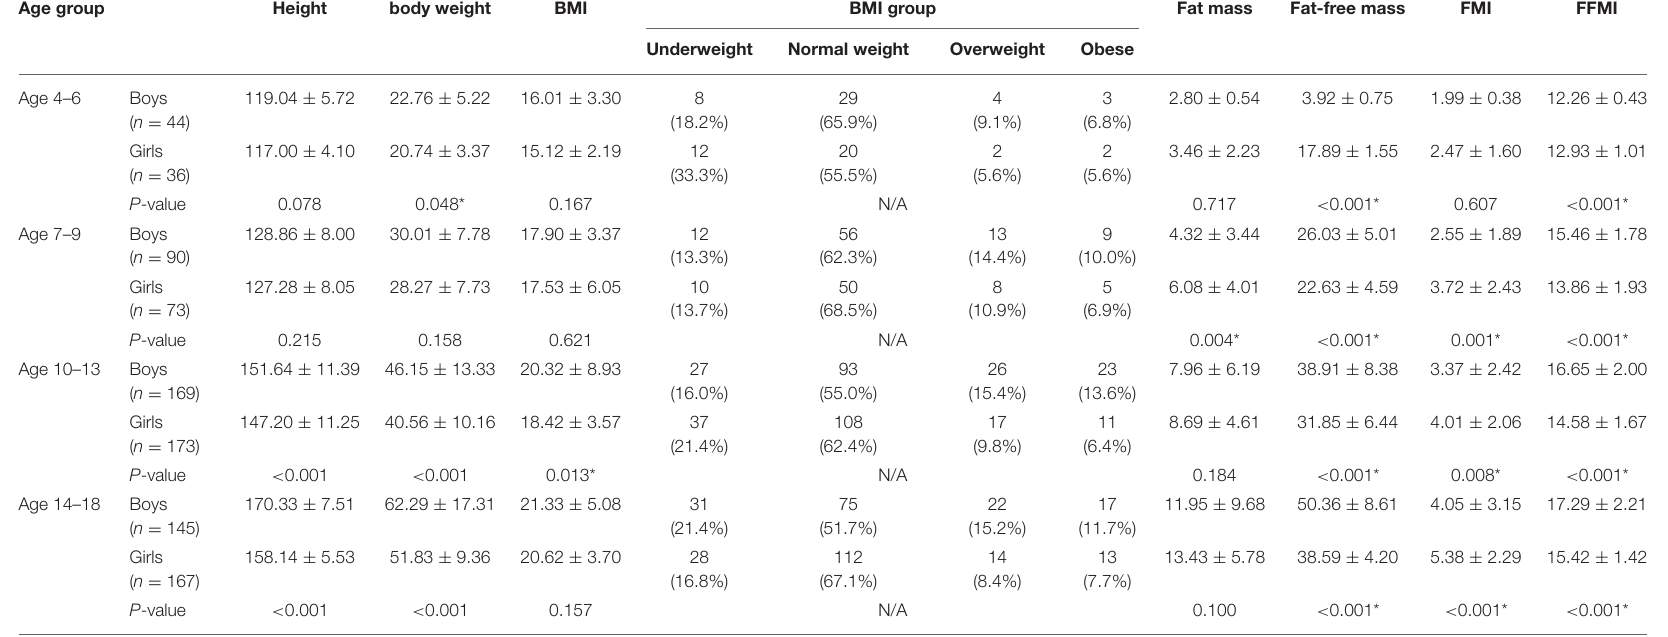
TABLE 1 | Comparison of body composition between two sexes in relation to age group. Age group Height body weight BMI BMI group Fat mass Fat-free mass FMI FFMI Underweight Normal weight Overweight